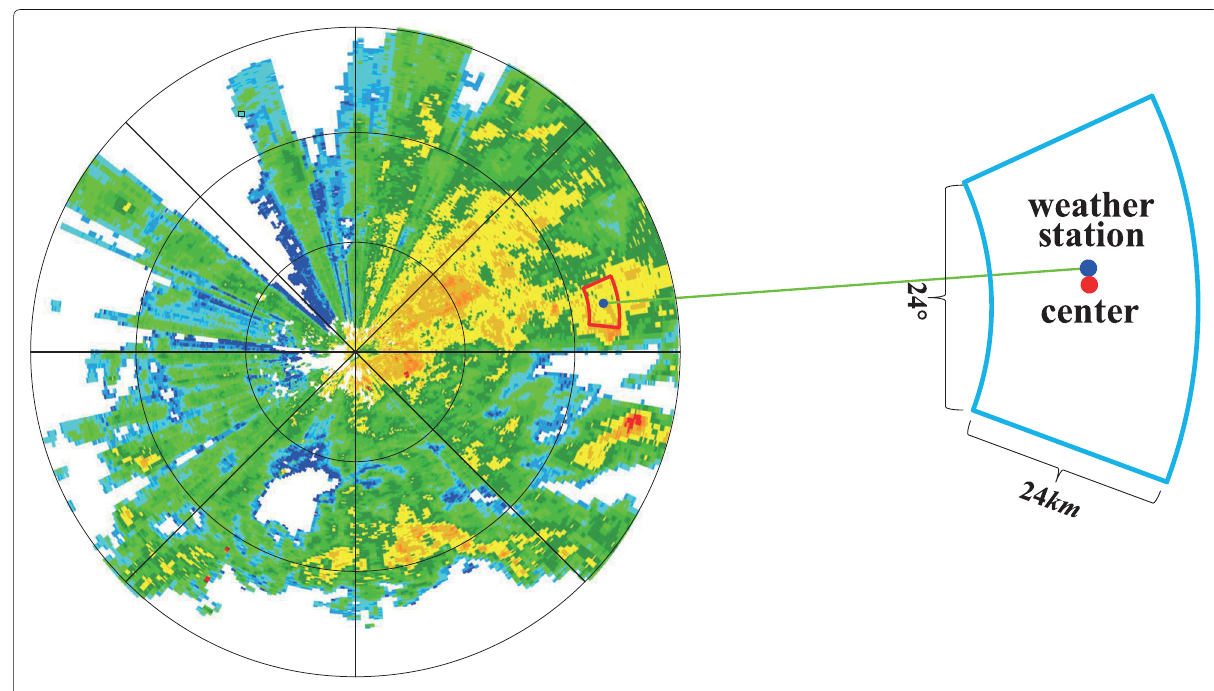
Fig. 1 The origin of radar data used for